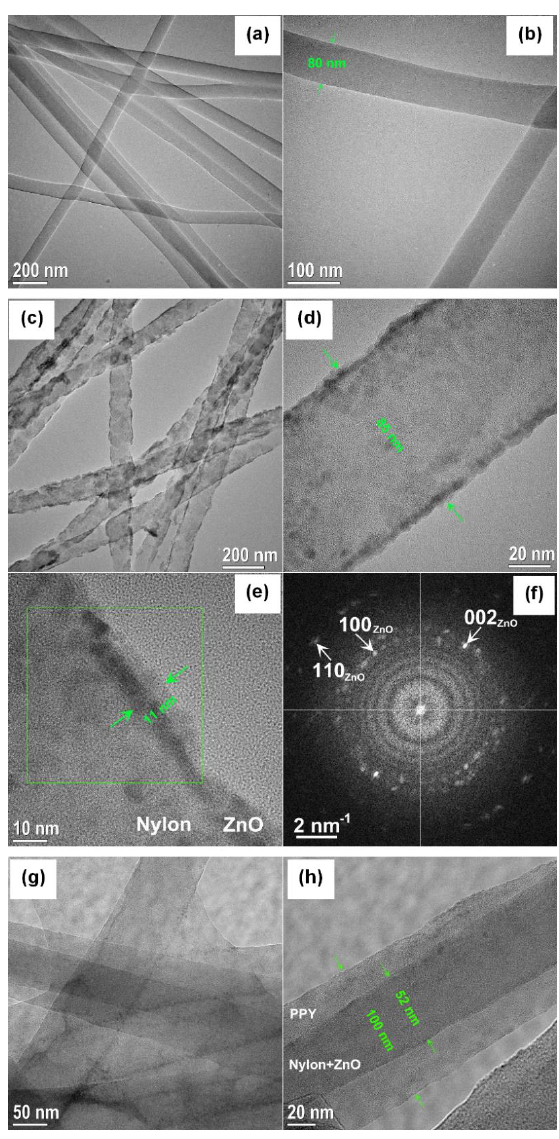
Figure 6. TEM images at different magnifications of ( a , b ) nylon, ( c , d ) nylon-ZnO and ( g , h ) nylon-ZnO/PPy; ( e ) high resolution transmission electron (HRTEM) image of an individual nylon-ZnO core–shell nanofiber and ( f ) FFT pattern corresponding to the area inside of green rectangle from the HRTEM image.